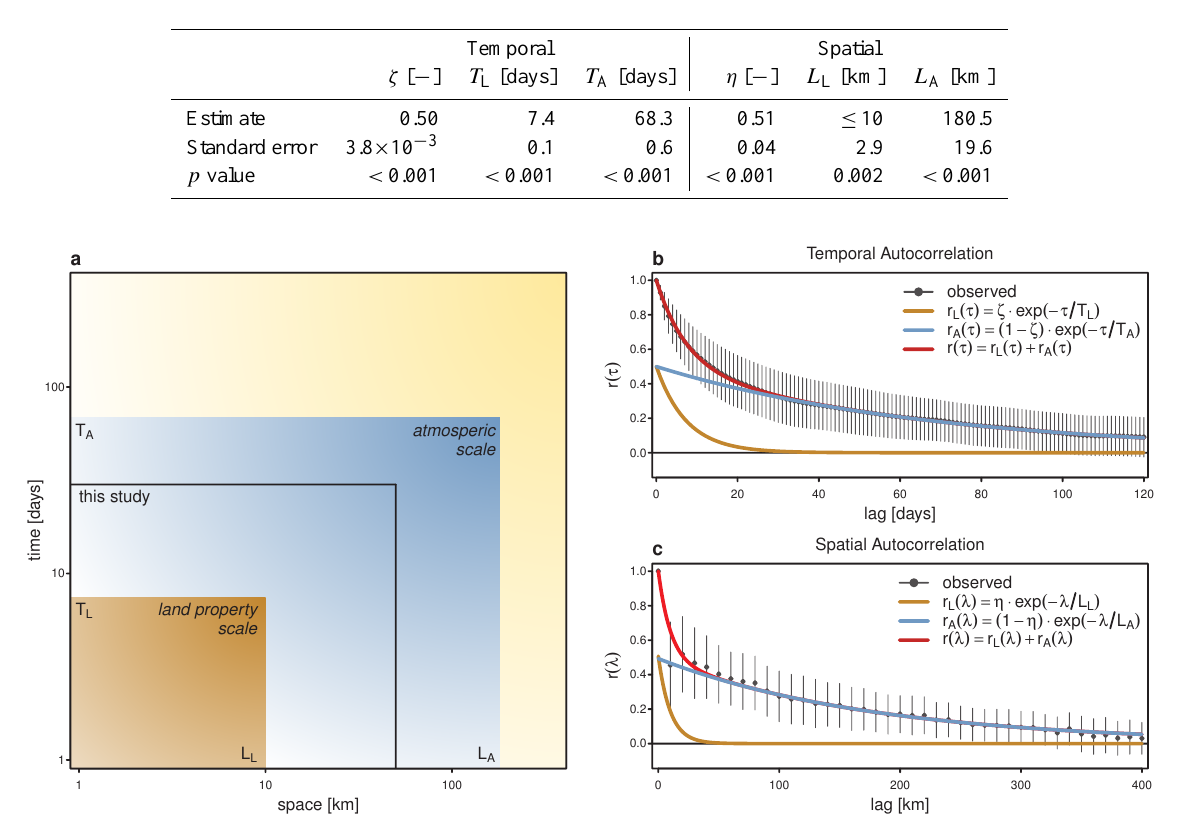
Table 2. Temporal and spatial scales of daily runoff in Europe: estimate, standard error and p value ( t test) of the scaling models (Eqs. 8, 9) fitted to observed temporal and spatial correlation functions using nonlinear least squares regression. Note that the lower limit of L L was set to the resolution of the empirical spatial correlation function (10km).